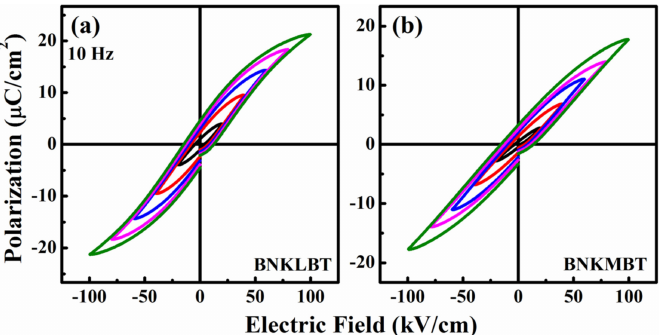
Figure 5. Ferroelectric analysis by polarization vs. electric field ( P − E loops) for dielectric capacitive measurements of ( a ) the BNKLBT ceramic and ( b ) the BNKMBT ceramic. Table 2. Dielectric capacitive performance of high-entropy BNKLBT and BNKMBT ceramics. Entropic